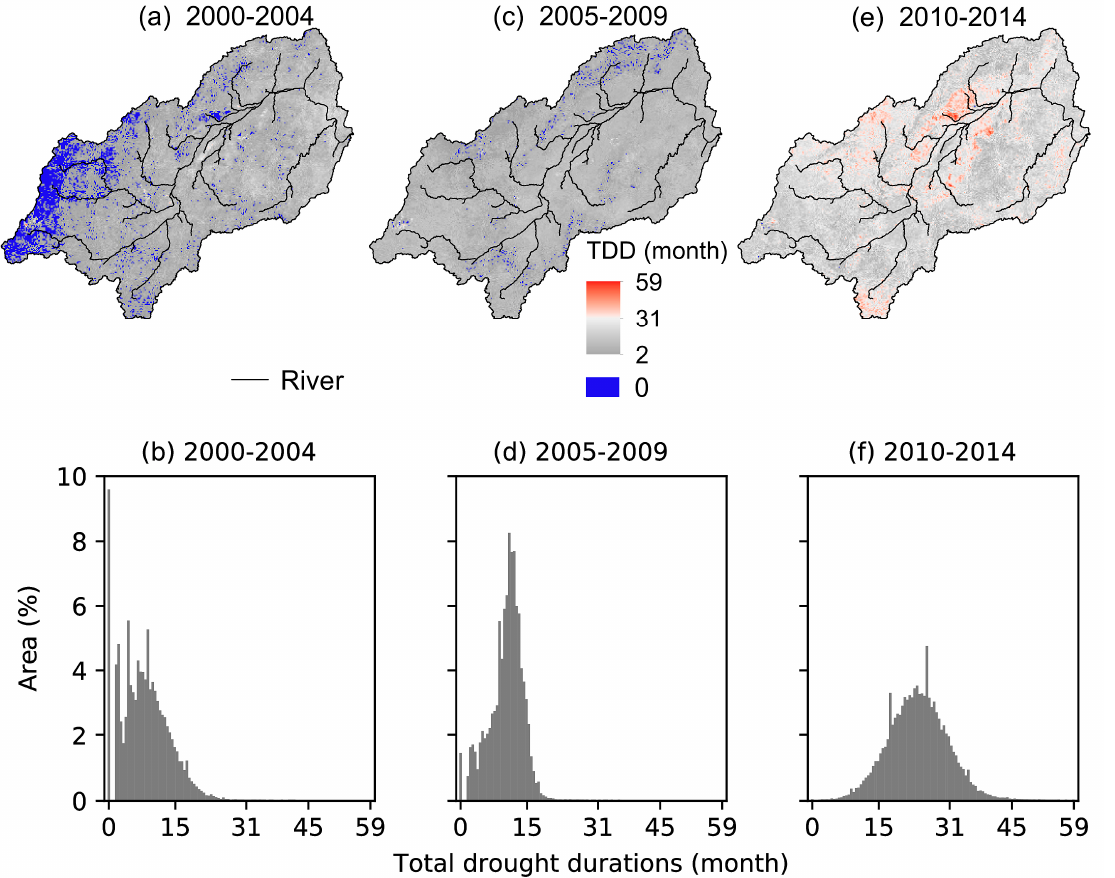
Figure 6. Map ( a ) and histogram ( b ) of total drought durations (TDD) during the first quinquennium. Map ( c ) and histogram ( d ) of TDD during the second quinquennium. Map ( e ) and histogram ( f ) of TDD during the third quinquennium.